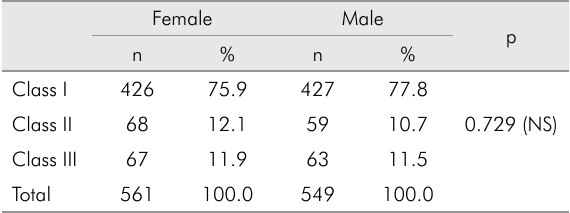
Table 1. Distribution of sagittal occlusal relationships in subjects by